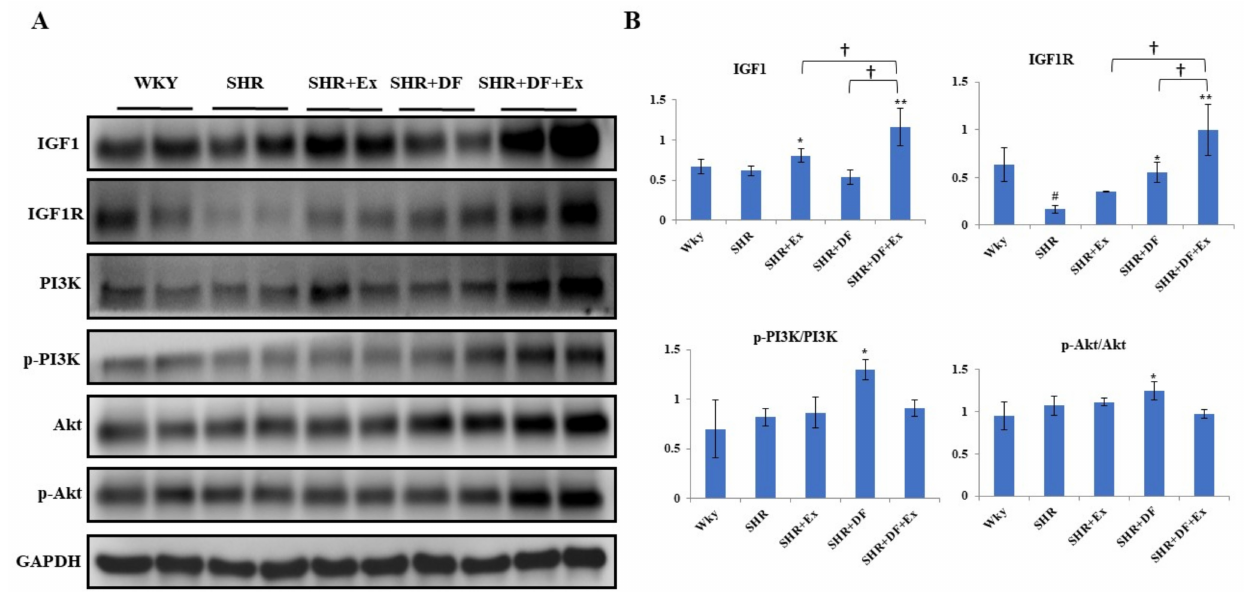
Figure 9. Effect of bioactive peptide and exercise on survival protein (PI3K/AKT) markers and IGF1 activation. ( A ) Expression of survival protein PI3K/AKT and IGF1. ( B ) Graph showing densitometric analysis. Each bar represents mean ± SD ( n = 8). # p < 0.01 compared to WKY, * p < 0.05 and ** p < 0.01 compared to SHR, † p < 0.05 compared to SHR + EX and/or SHR +